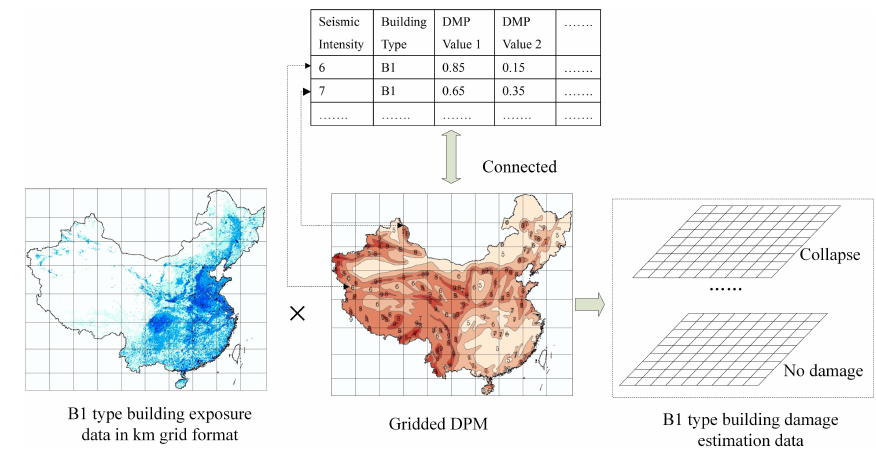
Figure 4. Building vulnerability data calculation process of the B1 type based on map algebra.